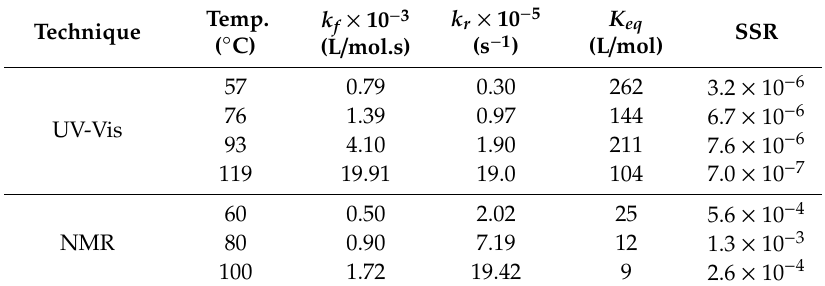
Table 2. Diels–Alder kinetic and thermodynamic constants for reaction of furfuryl alcohol / N -(2 -Hydroxyethyl)maleimide